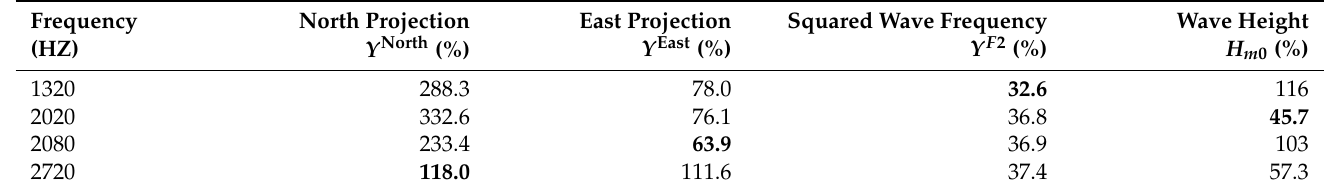
Table 2. RMSPE (Root Mean Square Percentage Error) values for XGBoost regression model equipped with 30 trees with max depth of 3 on the test set.